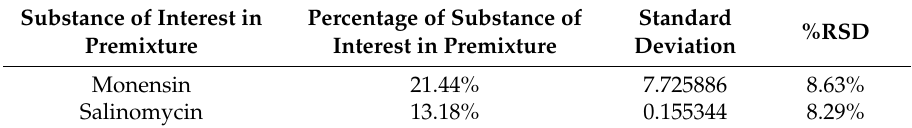
Table 3. Results of quantification of monensin and salinomycin in extracts from premixtures. Number of samples =